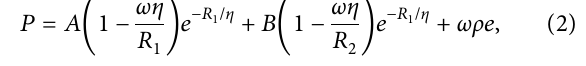
m, and w is the mass of ANFO explosive in kg.